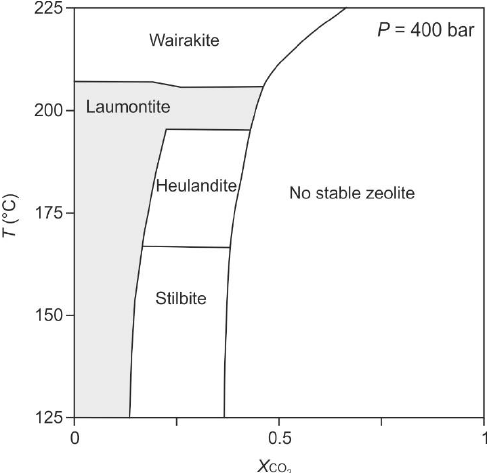
Figure 7. Results of the laumontite stability calculations on T-X CO2 field (THERIAK-DOMINO modelling software; [38].